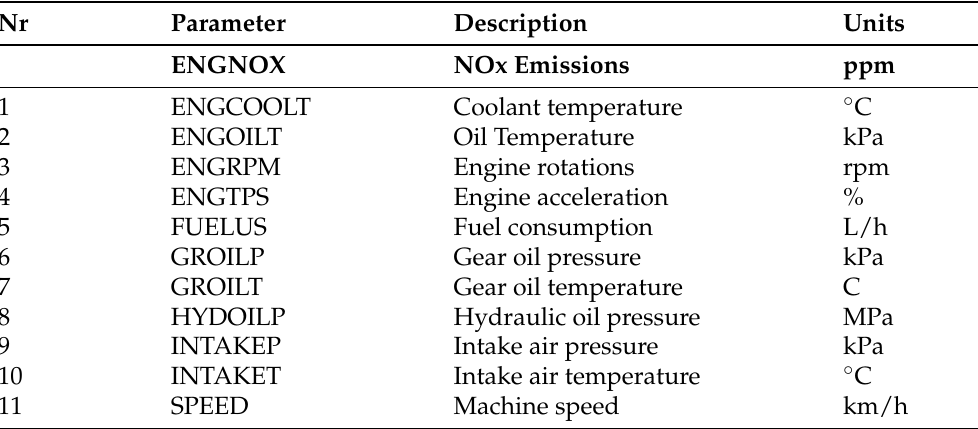
Table 4. Parameters of the monitoring system taken for